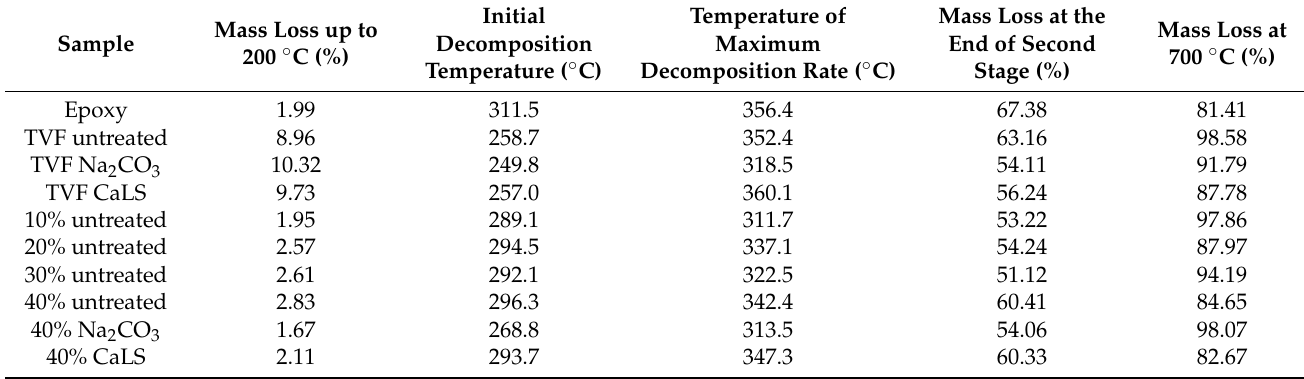
Table 1. Thermogravimetric parameters for neat epoxy, untreated and treated titica vine fiber (TVF) and their composites.